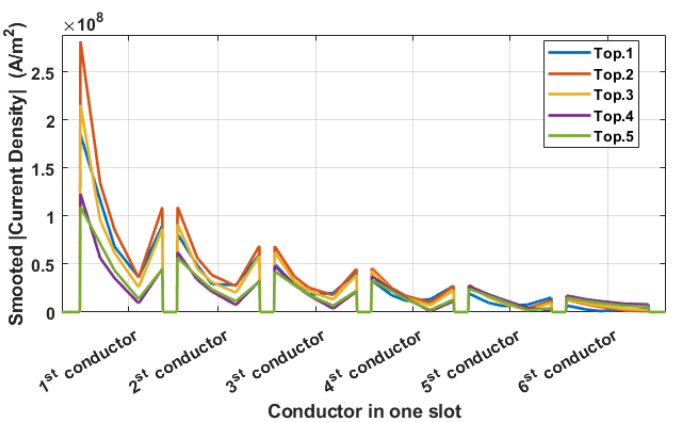
Figure 15. Instantaneous current density in the conductors within one slot of all five considered topologies, in the worst-case scenario.